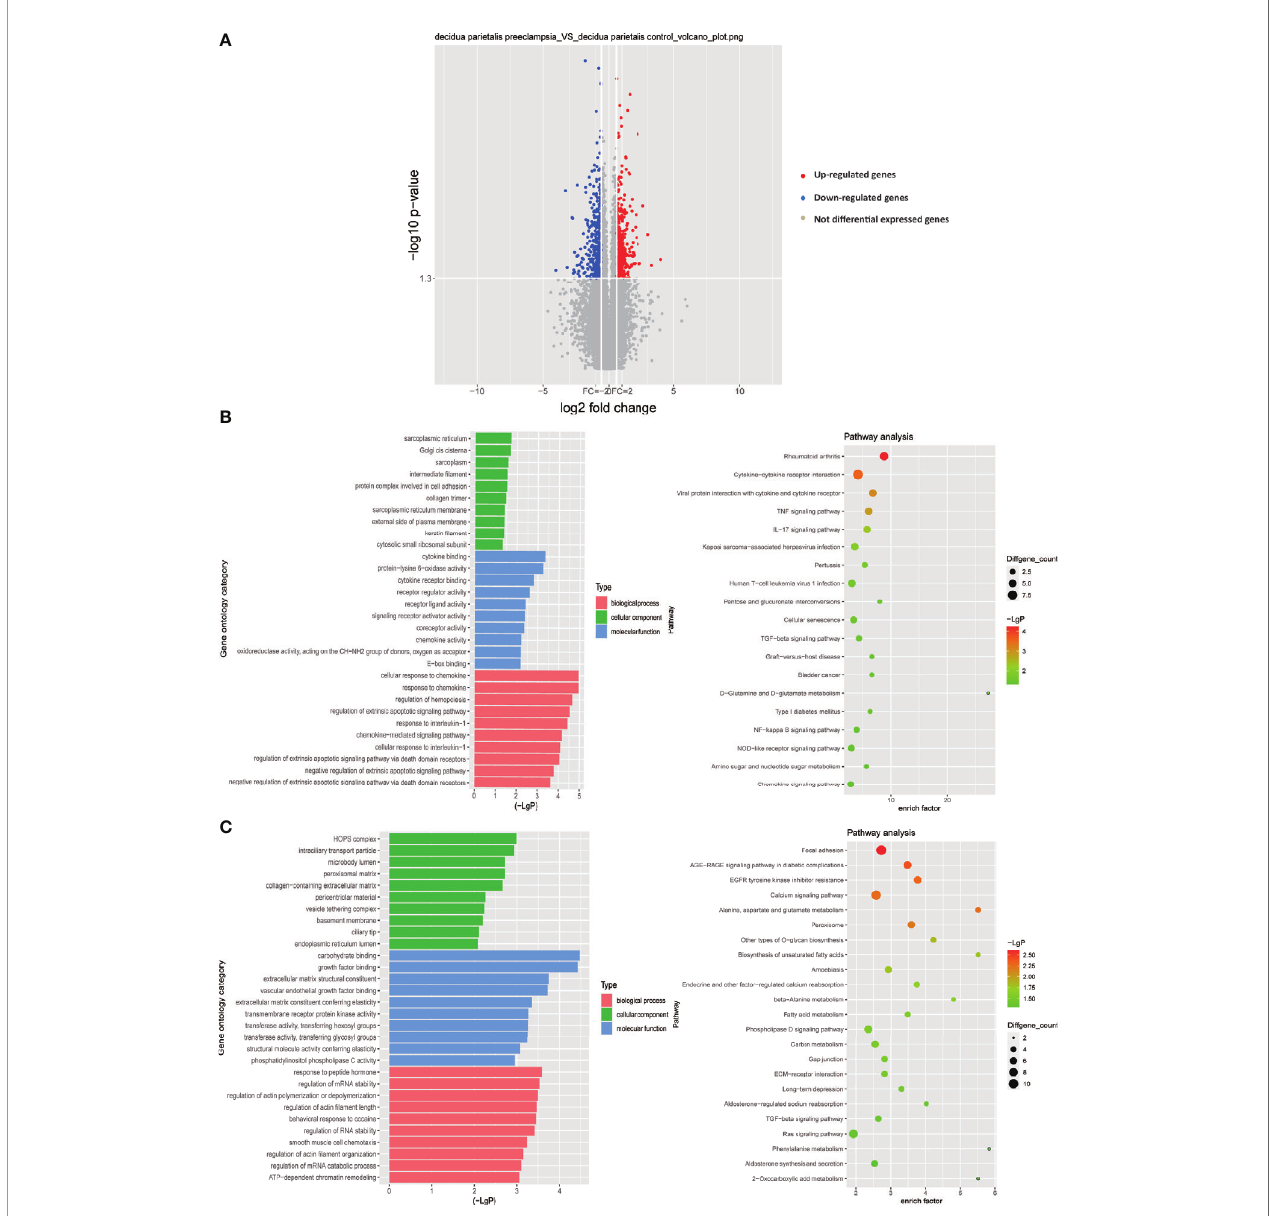
FIGURE 1 | Differential gene expression in the decidua parietalis between PE and control group. (A) Volcano fi gure showing the signi fi cantly DEGs in the decidua parietalis of the PE in comparison to controls. A red dot represents up-regulated DEGs with log2 ratio ≥ 1.5 and p-value <0.05; a green dot represents down-regulated DEGs with log2 ratio ≤ -1.5 and p-value <0.05. (B) GO analysis and KEGG pathway enrichment for the down-regulated DEGs. Left panel: GO functional classi fi cation of the down-regulated DEGs. Green, blue, and red represent the three classes of the GO term. The top ten enriched GO terms were shown in each class. Right panel: Scatter plot for the KEGG enrichment of the down-regulated DEGs. The enrich factor is the ratio of the down-regulated DEGs in a pathway to all the genes in this pathway. The top 19 pathways were shown with p-value< 0.05 in the fi gure. (C) GO analysis and KEGG pathway enrichment for the up-regulated DEGs. Left panel: GO functional classi fi cation of the up-regulated DEGs. Green, blue, and red represent the three classes of the GO term. The top ten enriched GO terms were shown in each class. Right panel: Scatter plot for the KEGG enrichment of the up-regulated DEGs. The top 23 pathways were shown with p-value<